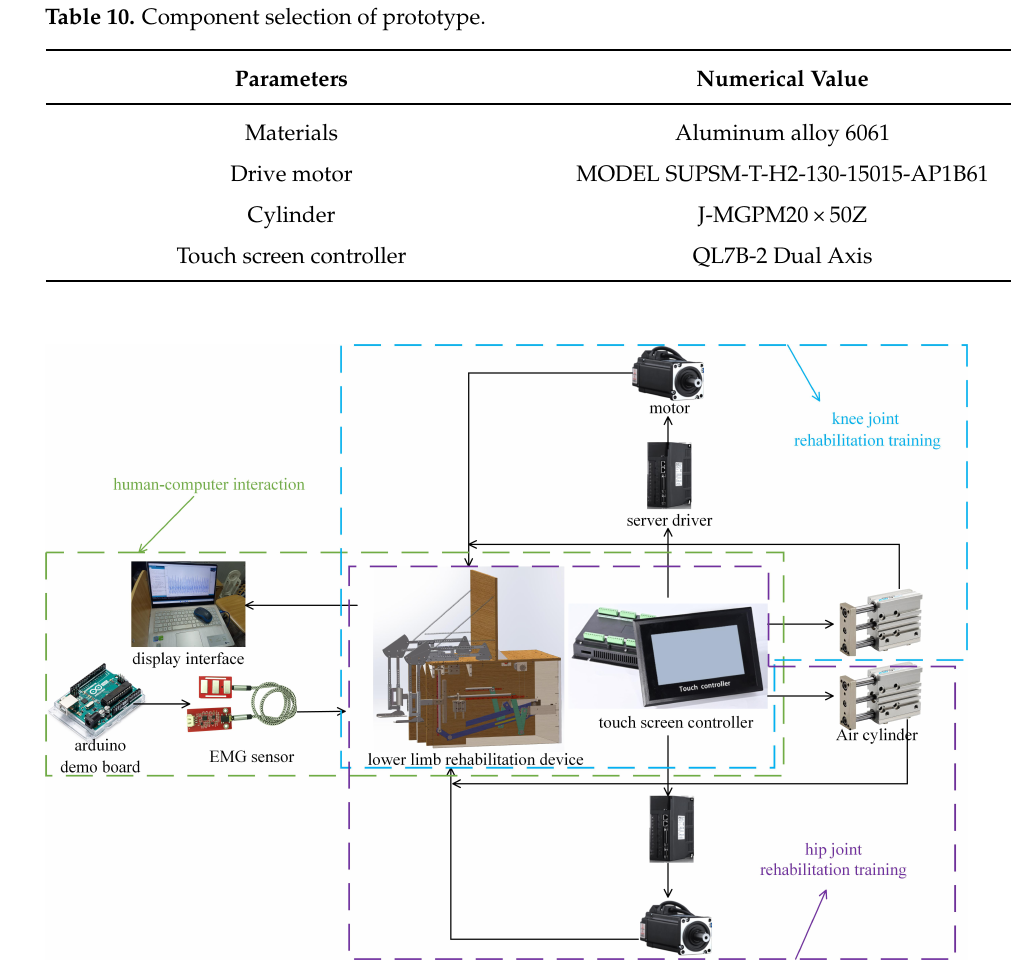
Figure 12. Schematic diagram of the control process.